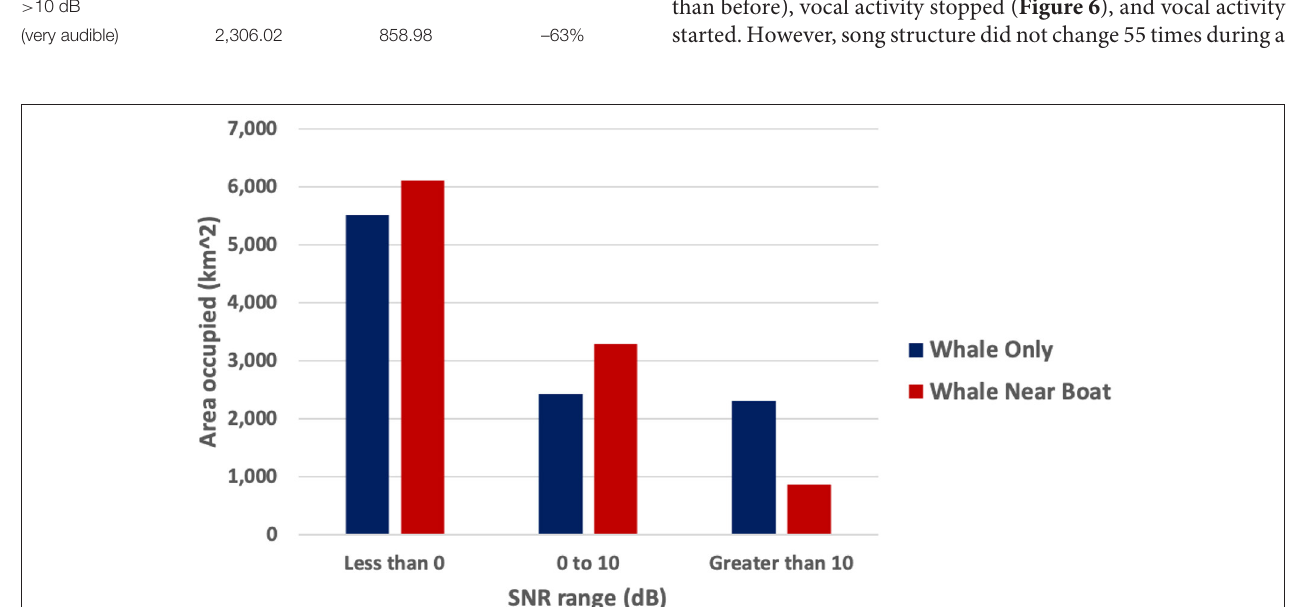
FIGURE 3 | Sept 5, 2019, scenario #1. Comparison bar plots of the area occupied by the three SNR bins of the hypothetical whale song when only ambient noise (blue/left bars) and one boat (red/right bars) was present (color online).